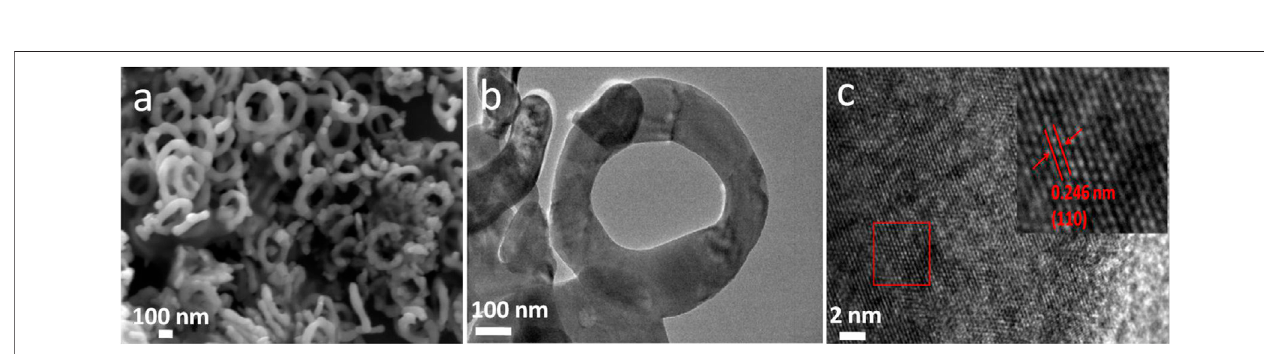
FIGURE 2 | (A,B) The SEM and TEM images of the nanorings after heat treatment in fl ow Ar atmosphere. (C) The corresponding HRTEM images of the nanoring showing an interplanar distance of 0.246 nm relative to the (110) Plane, which is consistent with the V 2 O 3 crystal (JCPDS card No. 34-0187).